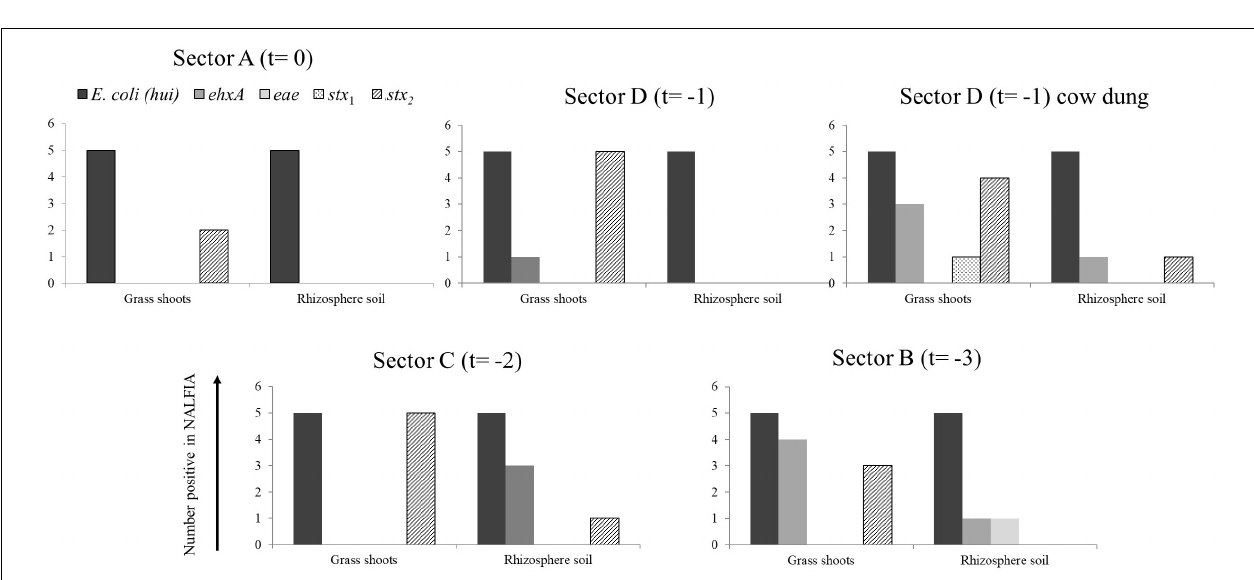
FIGURE 2 | Prevalence of Escherichia coli 16S rRNA and virulence genes, as determined by PCR-nucleic acid lateral flow immunoassay (NALFIA), in DNA extracts from grass shoots, rhizosphere soil, and stable manure taken in August 2014 (A) and August 2015 (B) and expressed as fractions of total sample numbers from each ecosystem. Number above bars represents the absolute numbers of positive reactions per target gene for each ecosystem.